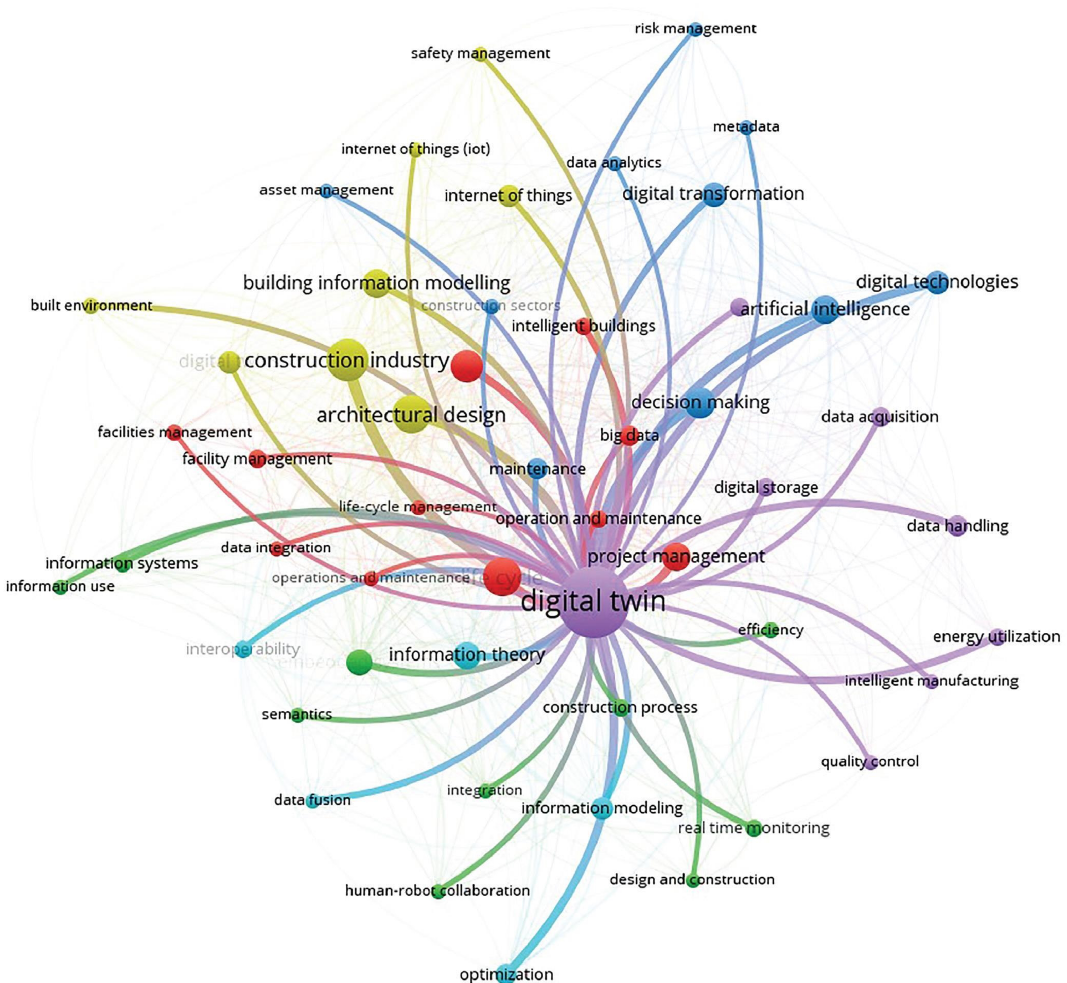
Figure 9: Te AEC-FM industry’s “Digital Twin” item co-occurrence network visualization map from 2016 to 2022 (up to February